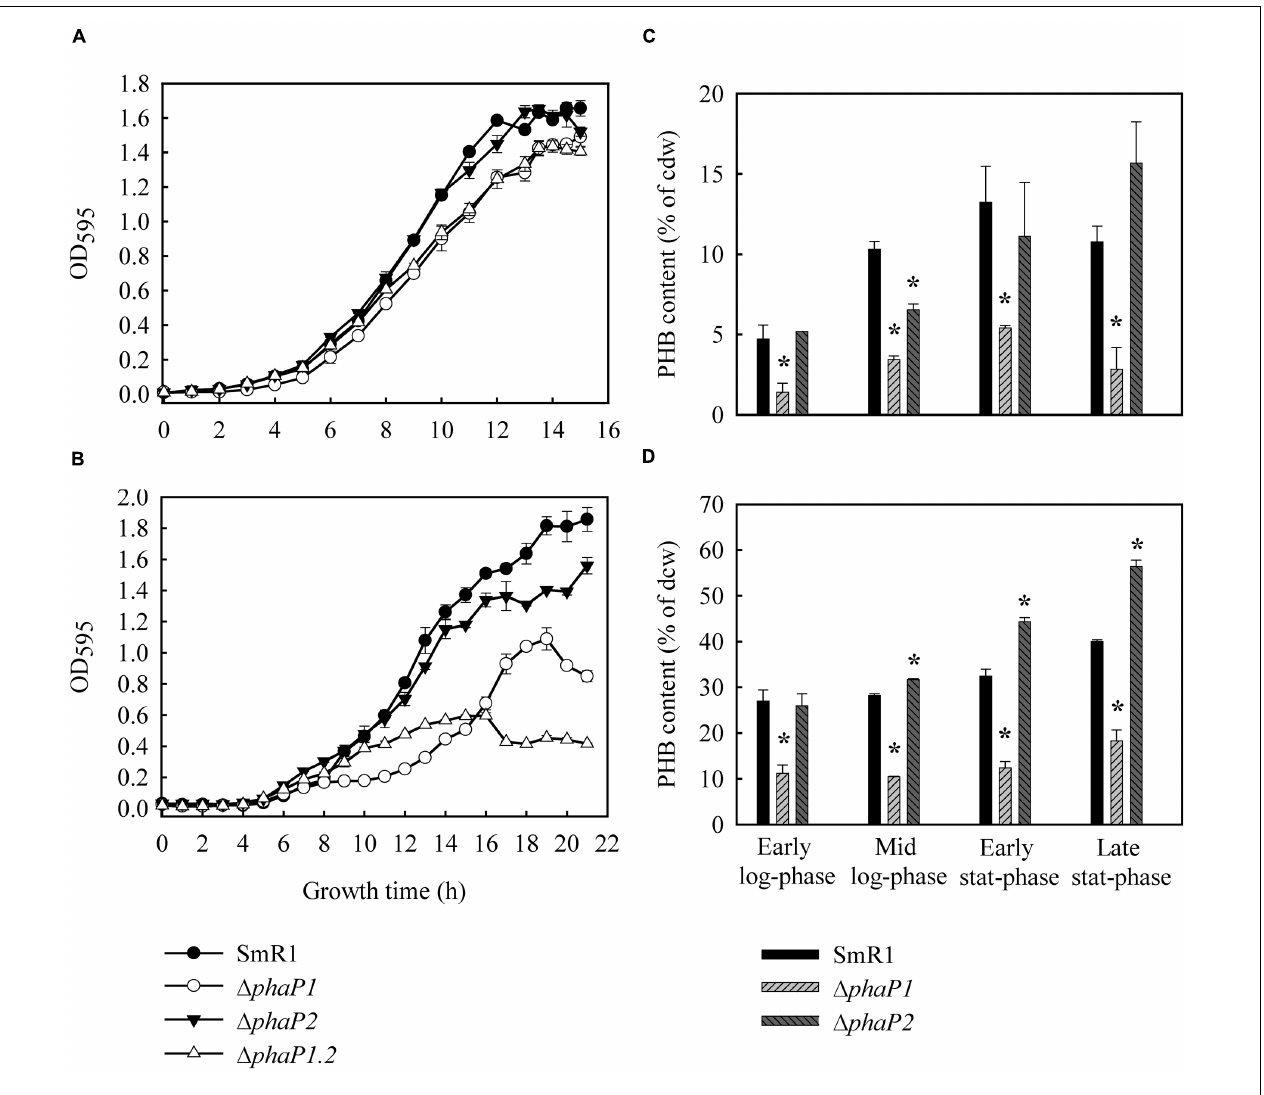
FIGURE 2 | Growth and PHB accumulation profiles of H. seropedicae SmR1 (parental strain) and the mutants (cid:49) phaP1 , (cid:49) phaP2, and (cid:49) phaP1.2 . Strains were grown in NFb medium with 20 mM of ammonium chloride and 37 mM DL -malate (A,B) or 25 mM (w/v) D-glucose (C,D) at 30 ◦ C (orbital agitation at 120 rpm). OD 595 growth data were obtained from three independent cultures, while PHB contents were determined on four independent samples. PHB levels in (cid:49) phaP1.2 were less than 1% at all growth phases. Where appropriate, statistical significance is shown ( ∗ p -value ≤ 0.05, independent two-sample t -test). The data obtained to SmR1 was used for normalization and determination of statistical